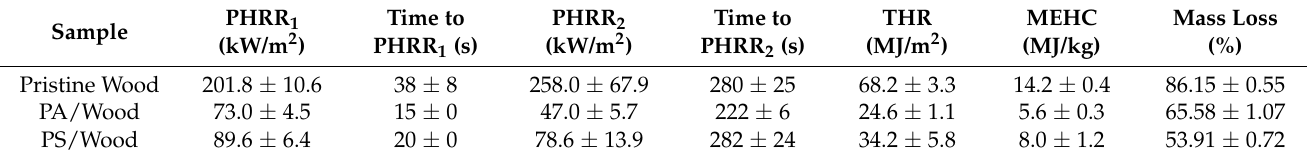
Figure 8. ( a ) LOI values and ( b ) HRR profiles of the wood samples. Table 4. Combustion data for the wood samples during